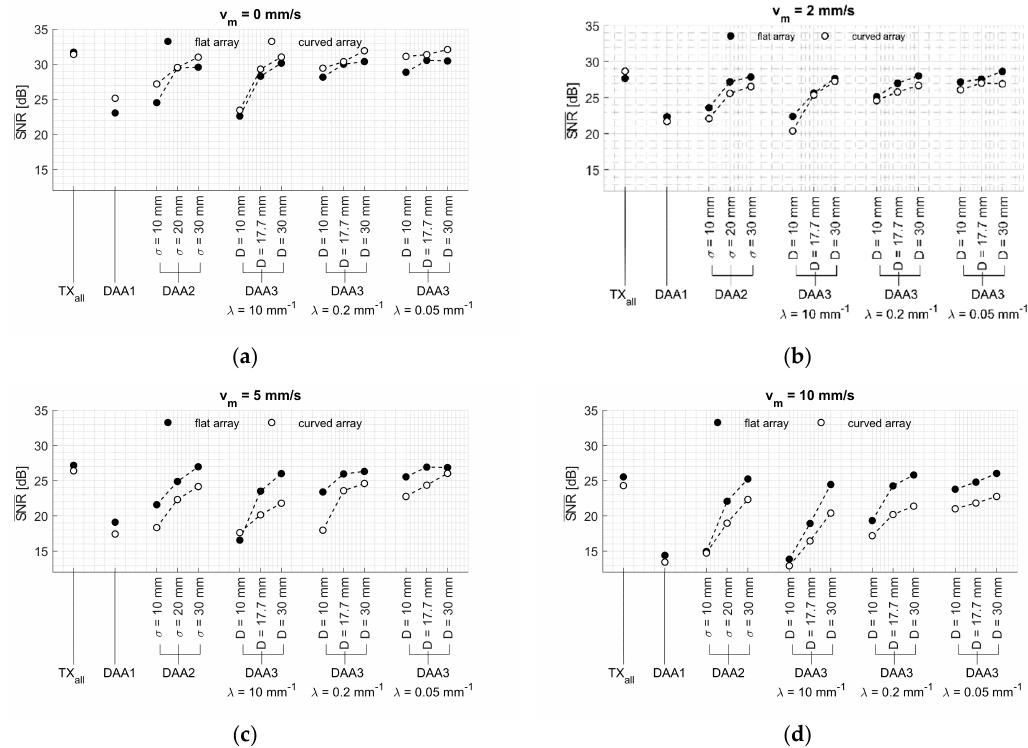
Figure 9. SNR measured during the static ( a ) and dynamic experiments ( b – d ), with velocities v m = 2 mm/s, v m = 5 mm/s and v m = 10 mm/s respectively. Both the results using a flat (black) and a curved (white) array are depicted. On the horizontal axis, the different apodization function and, if applicable, parameter settings are